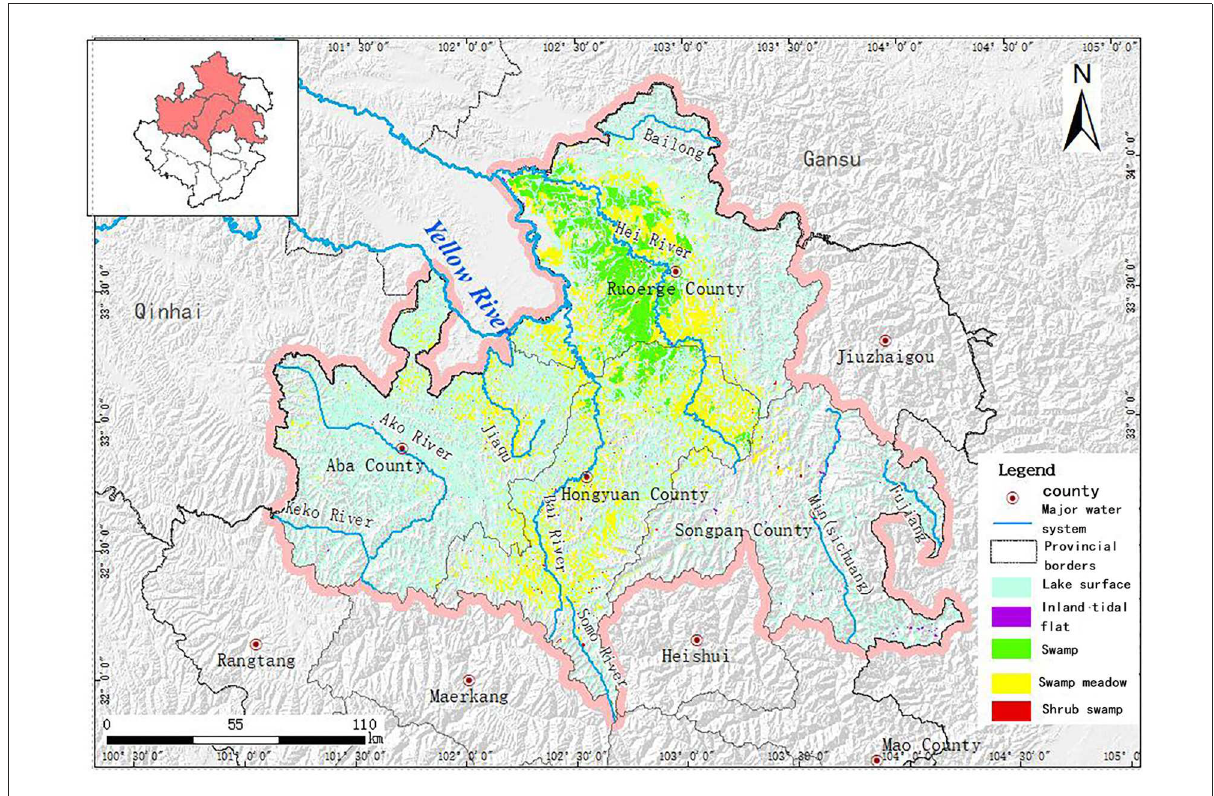
FIGURE3 Wetland resource distribution in the study area.